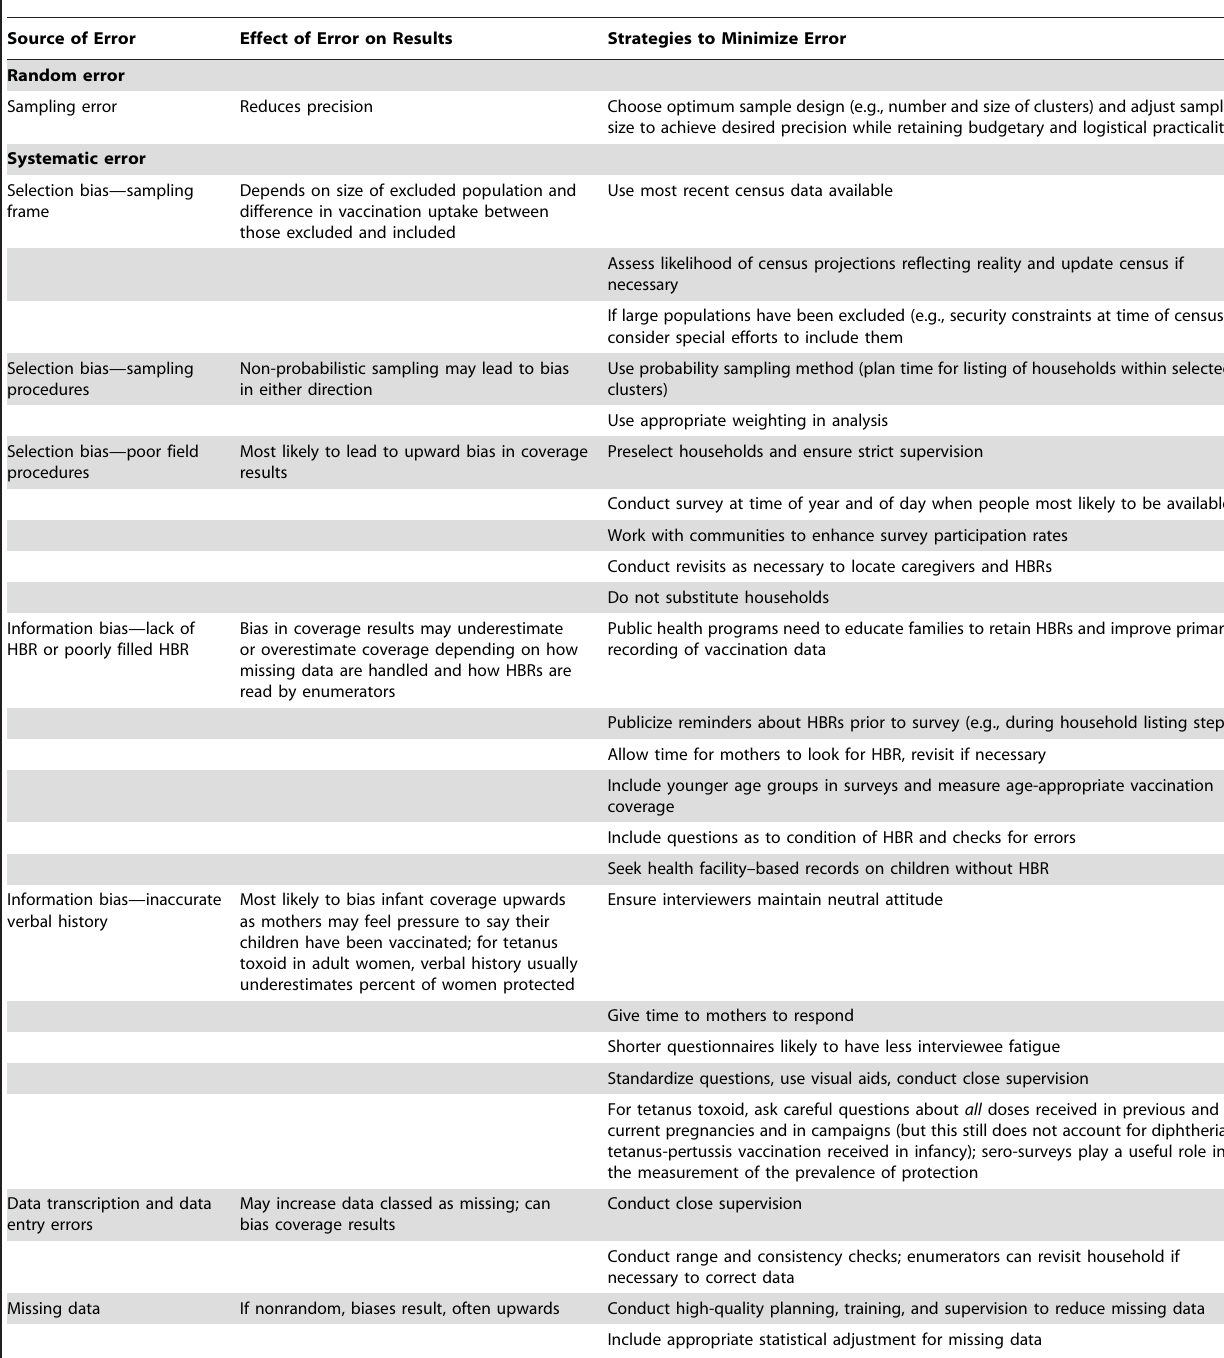
Table 2. Main potential sources of error and strategies to minimize them in population-based surveys measuring vaccination